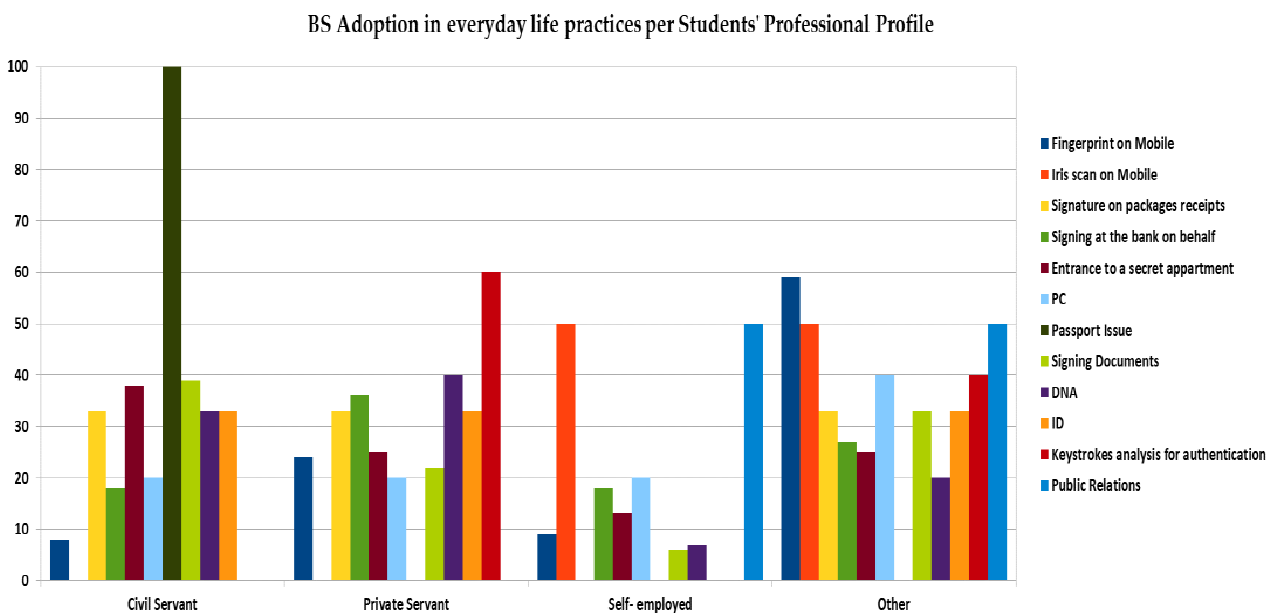
Figure 8. BS adoption in everyday life practices per students’ professional profile .